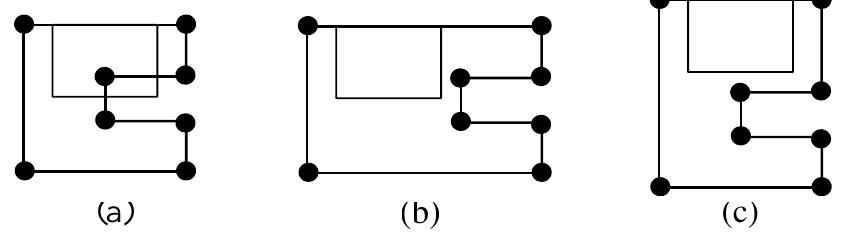
Figure 11. ( a ) A case where a label overlaps part of the drawing; ( b ) position the label to resolve overlaps by increasing the width of the drawing; ( c ) position the label to resolve overlaps by increasing the height of the